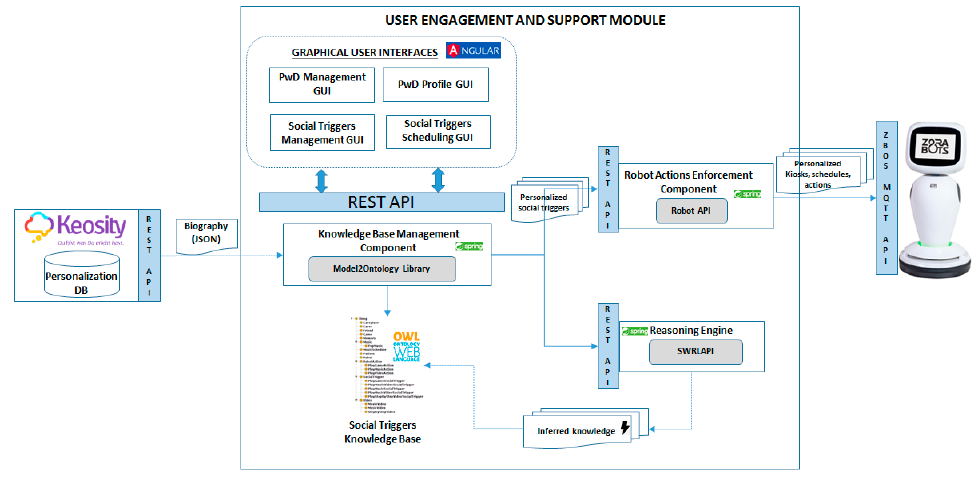
Figure 6. User-engagement and support module implementation.